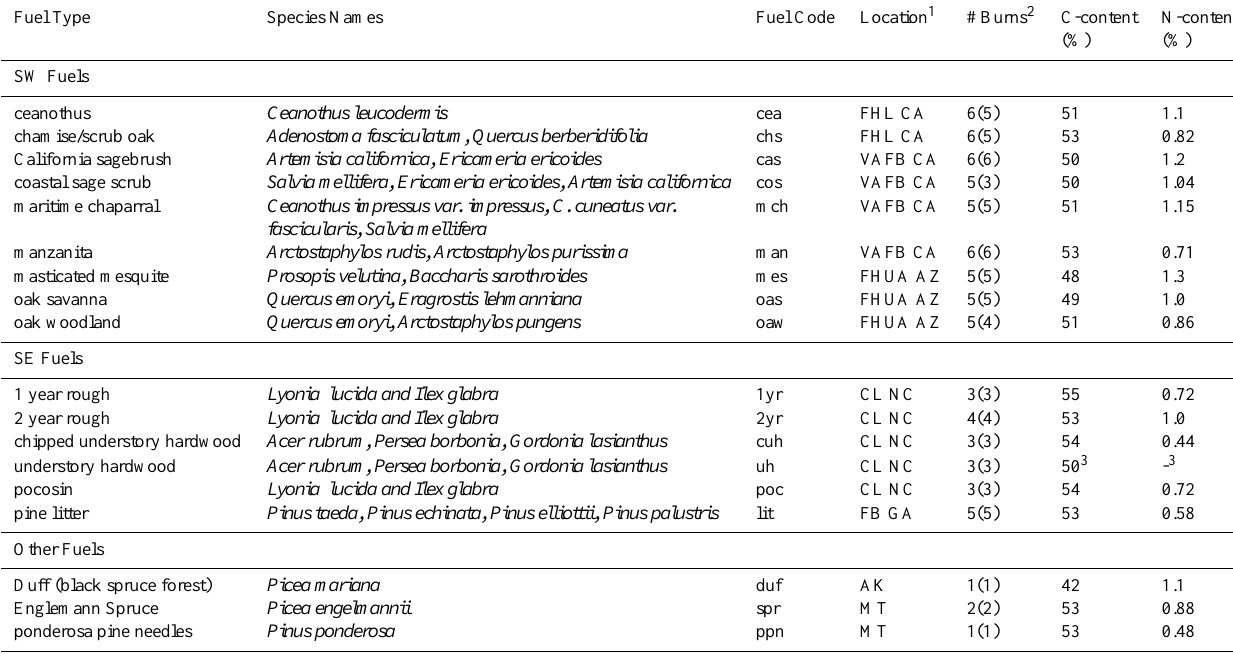
Table 1. Summary of vegetation burned and fuel elemental analysis (see Sect. 2.2 for fuel